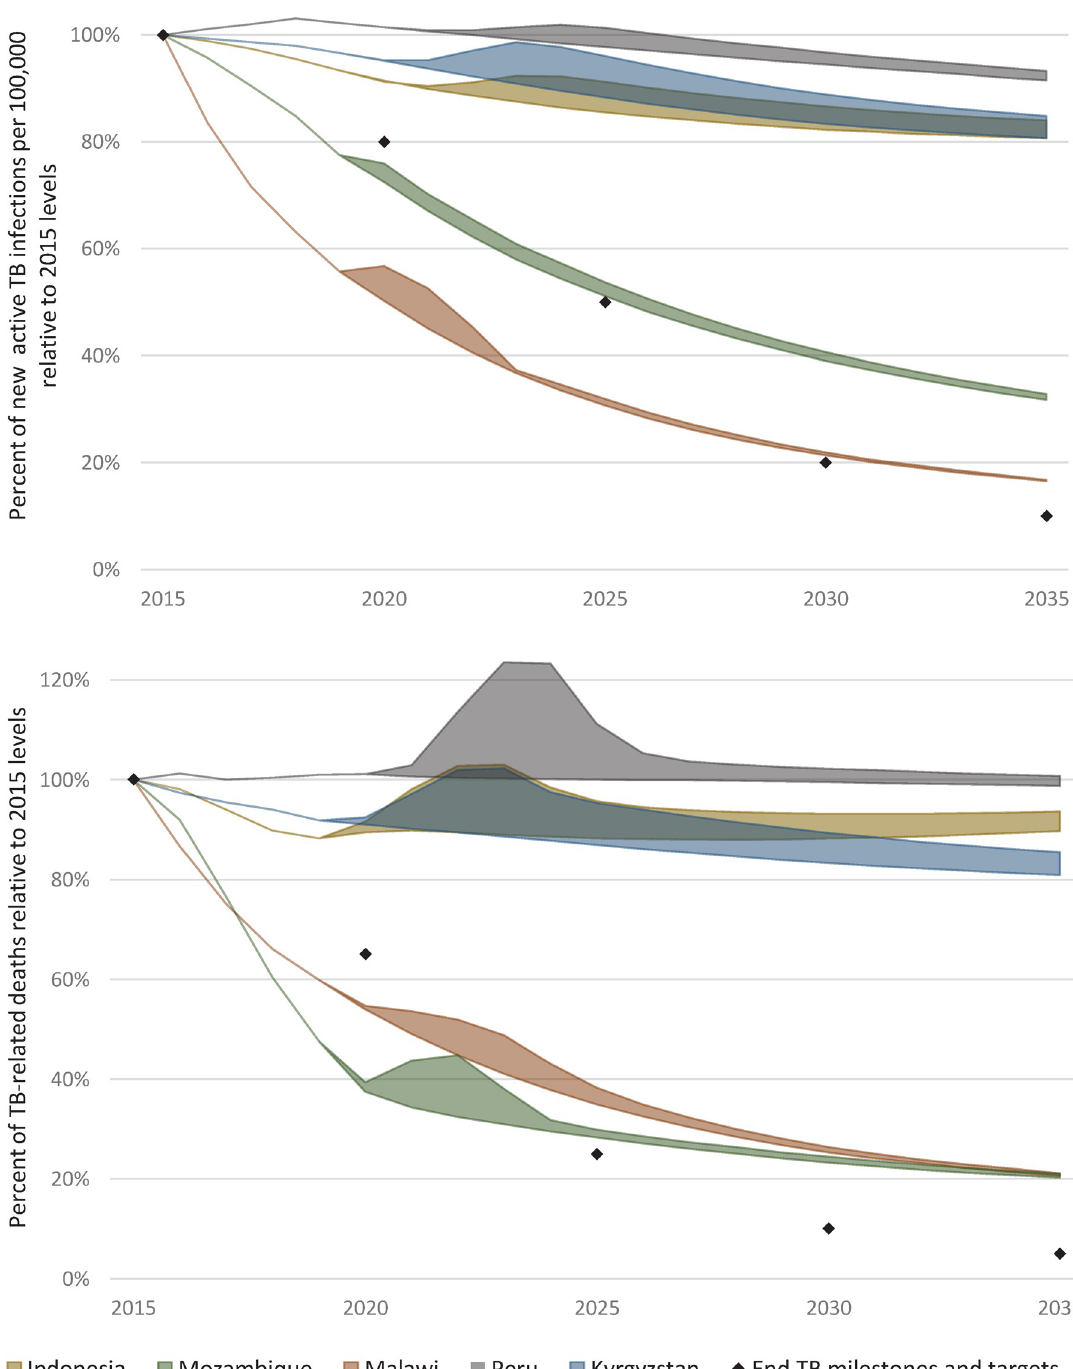
Fig 5. Impact of COVID-19-related disruptions to TB services on achieving the End TB milestones and targets, 2015 to 2035.